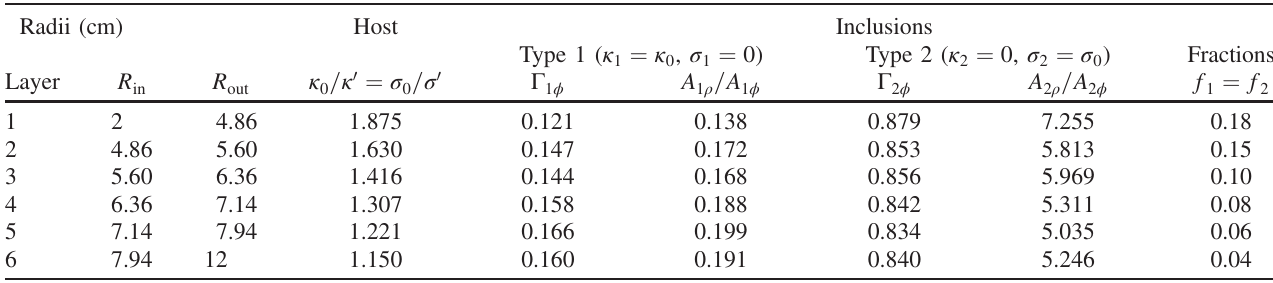
TABLE I. Geometrical, structural, and constitutive parameters of the ideal-parameter synthesis, from the piecewise-constant nominal profiles in Fig. 3(b), assuming neutral inclusions ( κ 1 ¼ κ 0 , σ 2 ¼ σ 0 ) with κ 2 ¼ 0 and σ 1 ¼ 0 . Radii